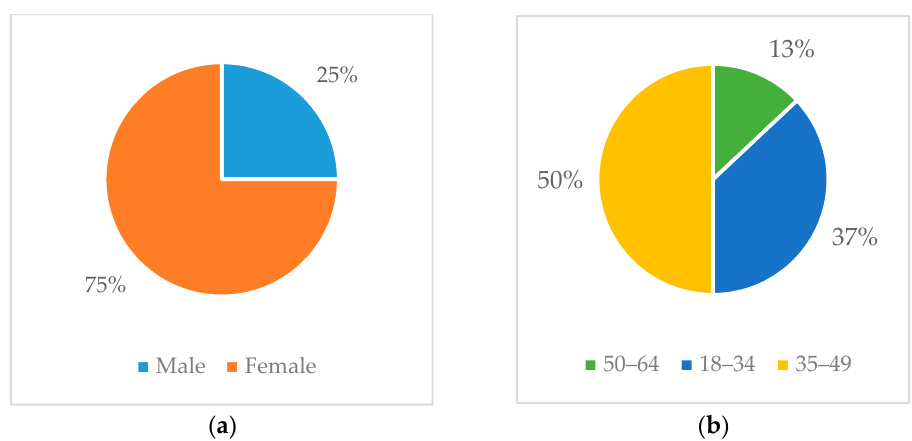
Figure 16. ( a ) Gender distribution and ( b ) age distribution of HypnOS’s evaluation participants.